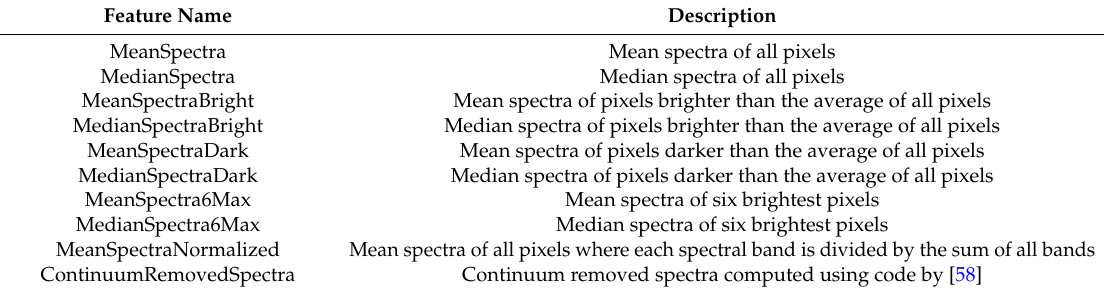
Table 6. Spectral features derived from the FPI data cubes. Each spectrum includes 33 spectral bands.